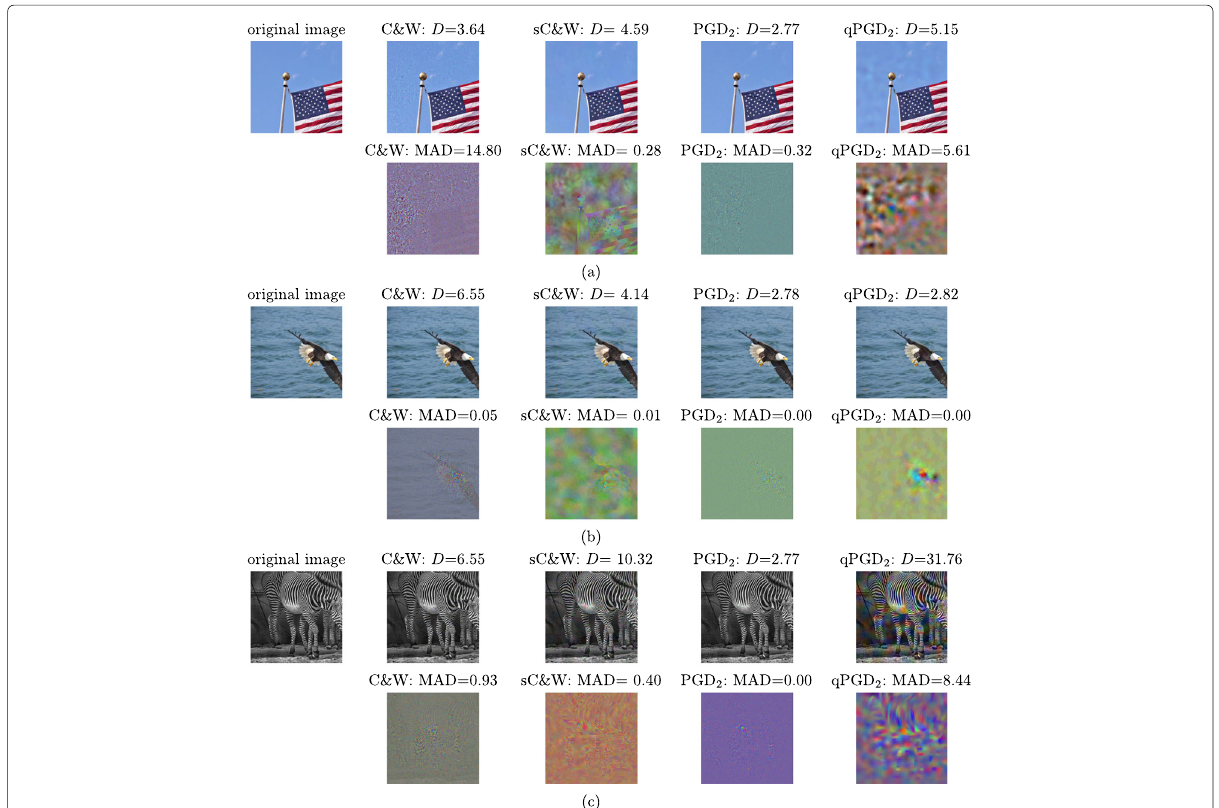
Fig. 3 Original image x o (left), adversarial image x a = x o + r (above) and scaled perturbation r (below; distortion D = (cid:4) r (cid:4) and MAD scores) against InceptionV3 on ImageNet. Scaling maps each perturbation and each color channel independently to [0,1]. The perturbation r is indeed smooth